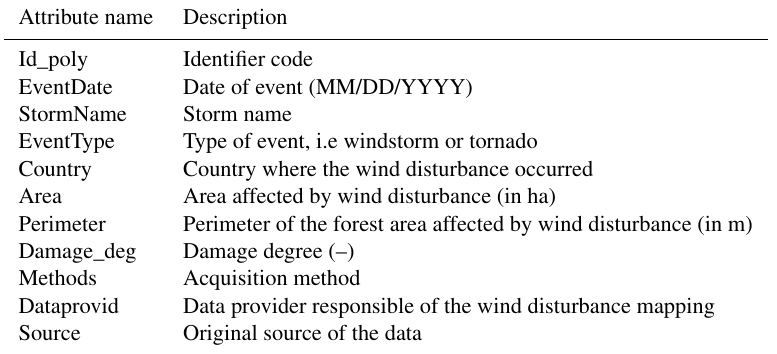
Table 3. Attribute table of the FORWIND database. The name and description of the attributes associated with each wind disturbance in FORWIND and listed in the .dbf file are given. Missing data are reported as −